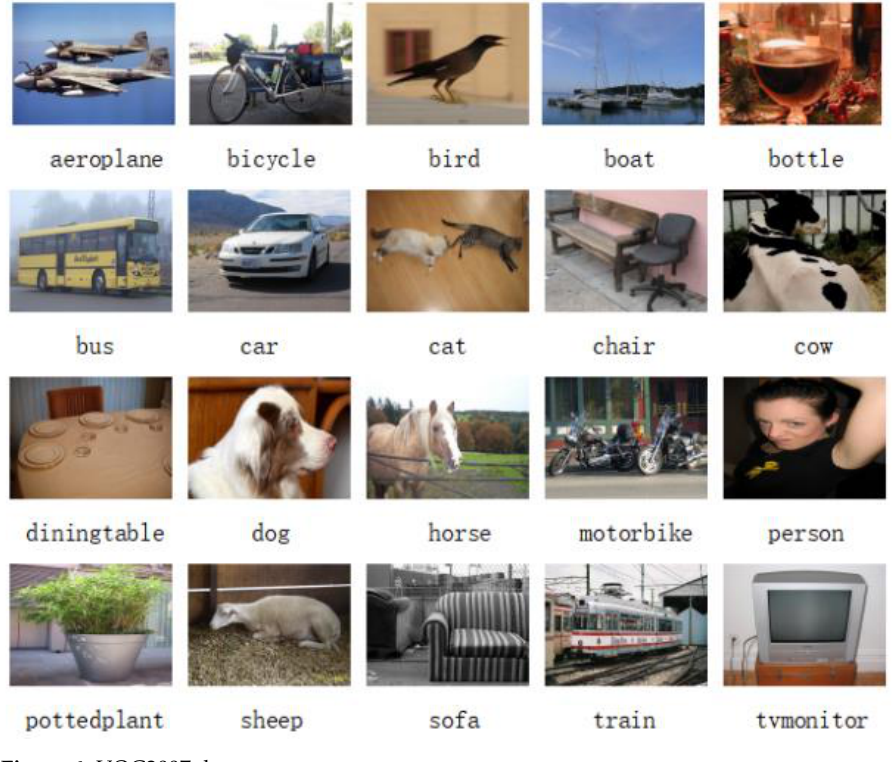
Figure 6. VOC2007 dataset.